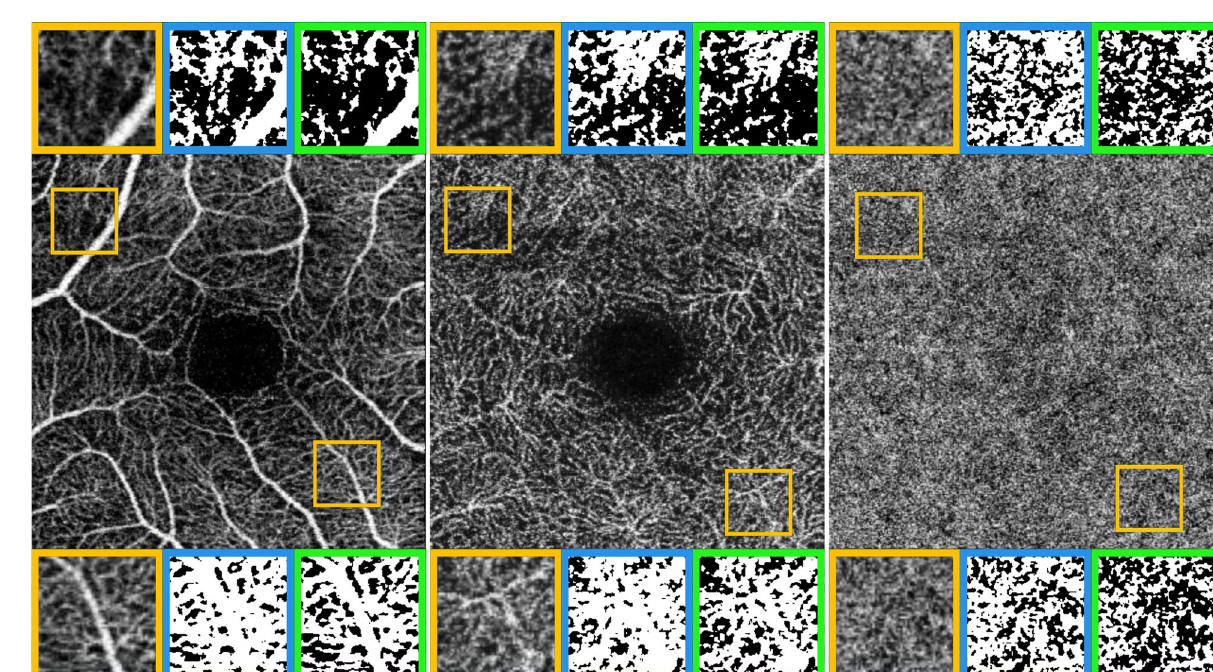
Figure 3. Fixed and Mean thresholding effects on OCTA images binarization. SCP, DCP and CC OCTA reconstructions are respectively shown in left, central and right images. Two detailed magnifications are taken in temporal and nasal sectors (orange squares). For all the retinal plexa, Fixed threshold (blue square) turned out to provide a more likely binarization result, compared to Mean threshold (green square) resulting in a visually evident